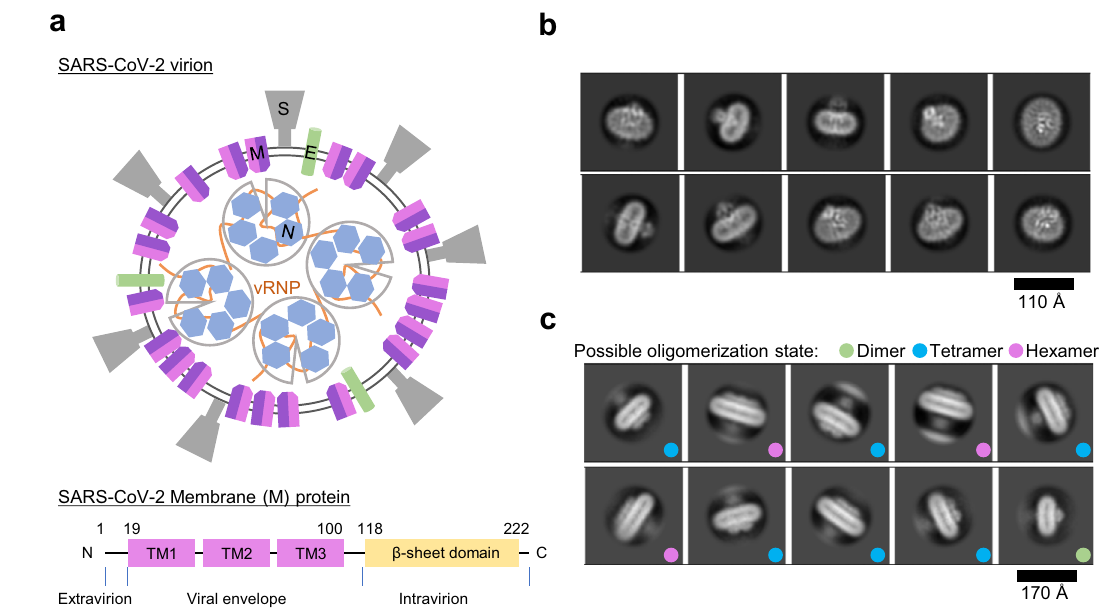
Fig. 1 | M protein forms dimer and higher-order oligomers. a Schematic view of SARS-CoV-2 virion. Four structural proteins, M, N, S, and E and genomic RNA are shown in different colors. The N protein and RNA molecules form viral ribonu- cleoprotein (vRNP) complexes. b Representative 2D class average images of M